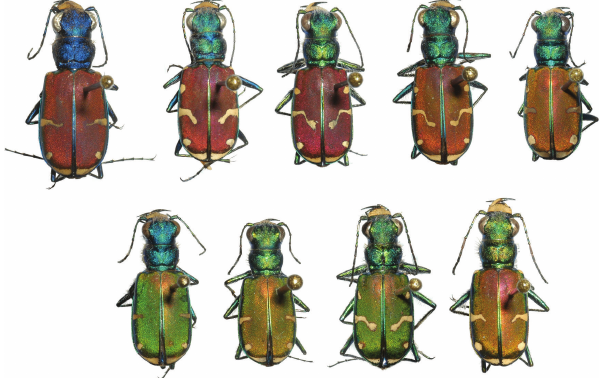
Figure 13: Series of Cicindela splendida showing variation in maculation and color. Top row: Largely pure C. splendida , bottom row: Hybrid C. denverensis × splendida